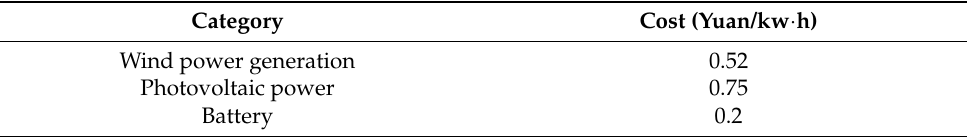
Table 6. Generating